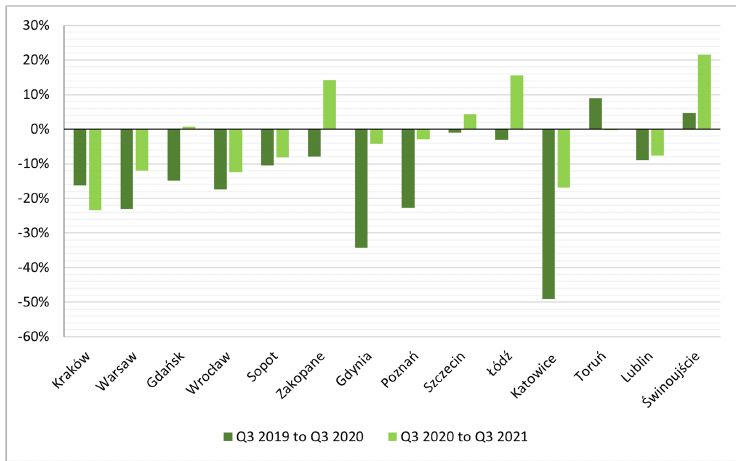
Figure 7. Indices of dynamics of changes, Q3 2019 to Q3 2020 and Q3 2020 to Q3 2021. Int. J. Environ. Res. Public Health 2022 , 19 , x FOR PEER REVIEW